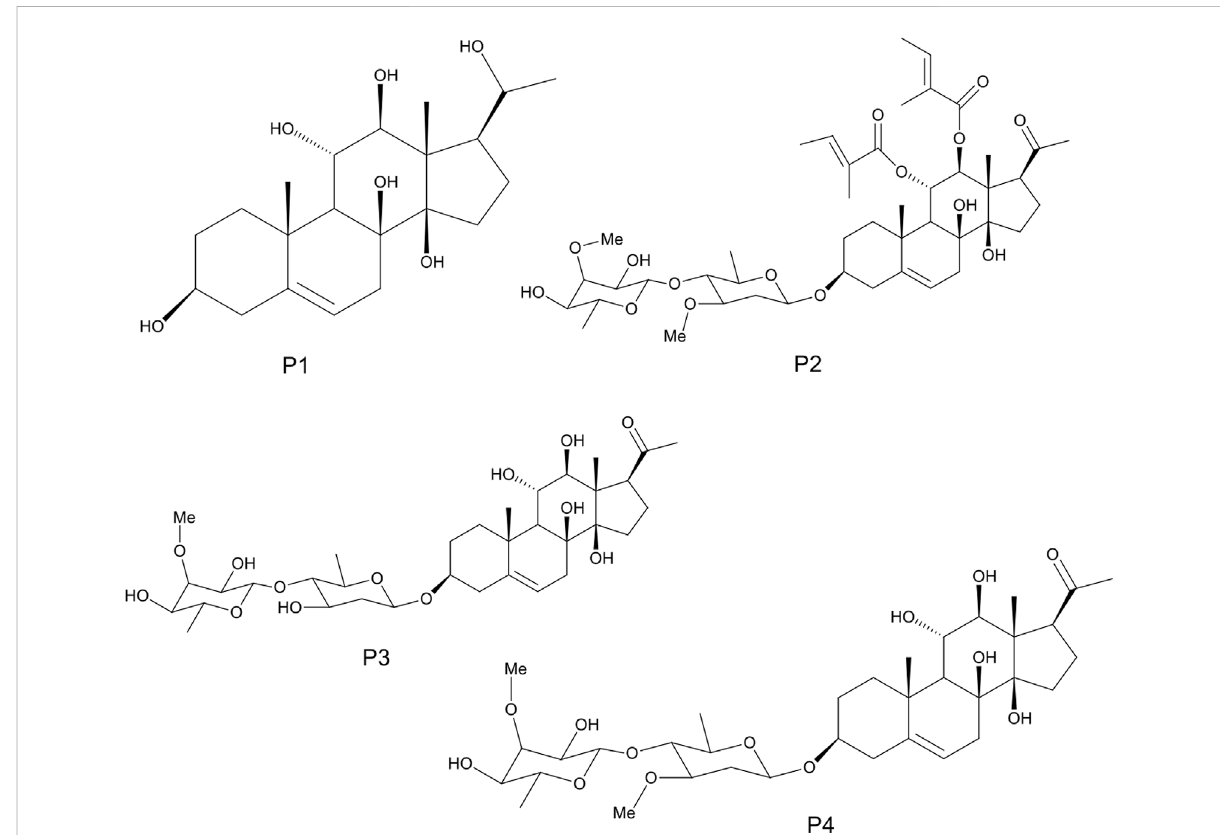
FIGURE 1 The 2D structures of marsectohexol (P1) and the pregnane glycosides, viz: iloneoside (P2), 3-O-[6-deoxy-3-O-methyl- β